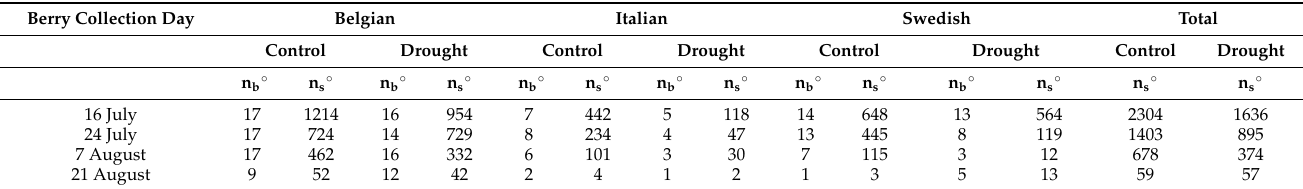
Table 1. Number of stratified batches (n b ◦ ) and sum of stones in the batches (n s ◦ ), for each provenance of the mother plants, for each treatment of the mother plants in 2020 (control and drought) and for each berry collection day in